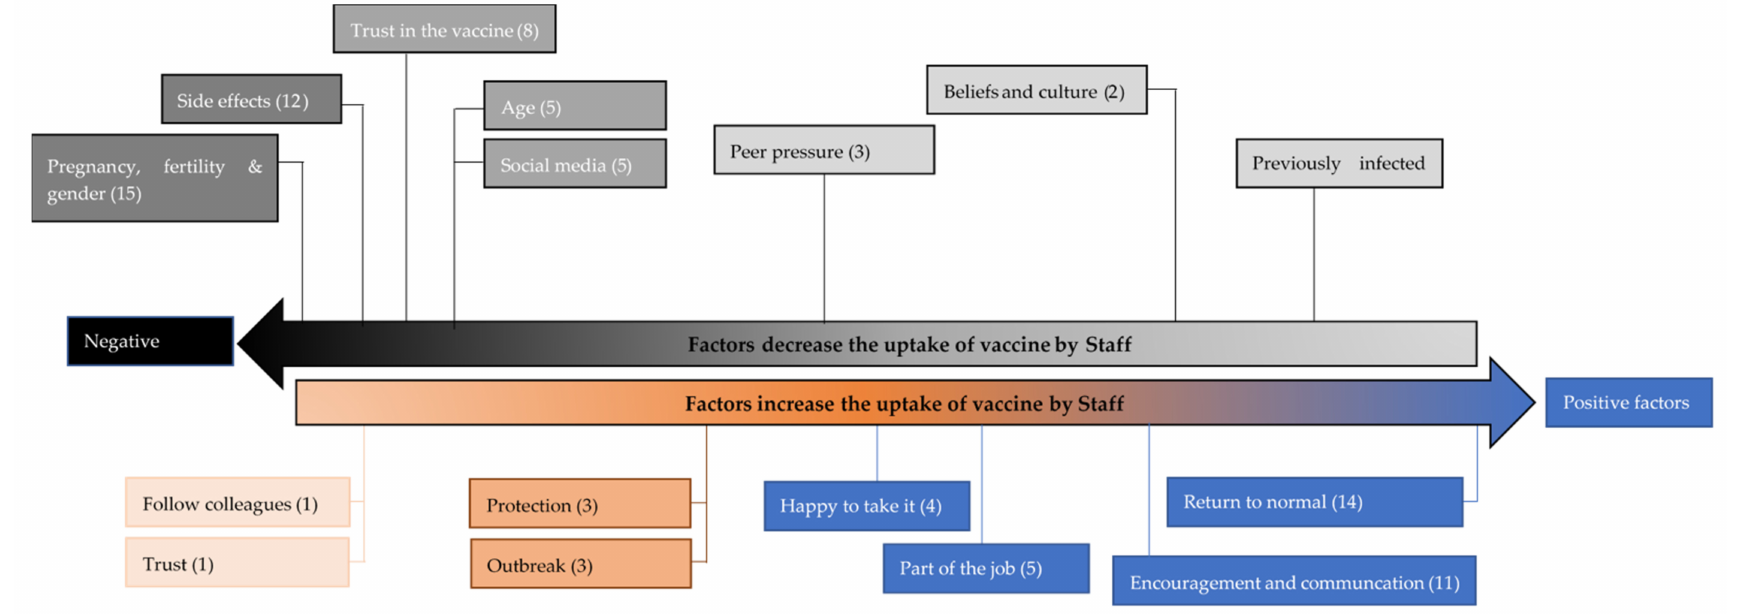
Figure 3. Positive and negative codes that affect the uptake of vaccine by